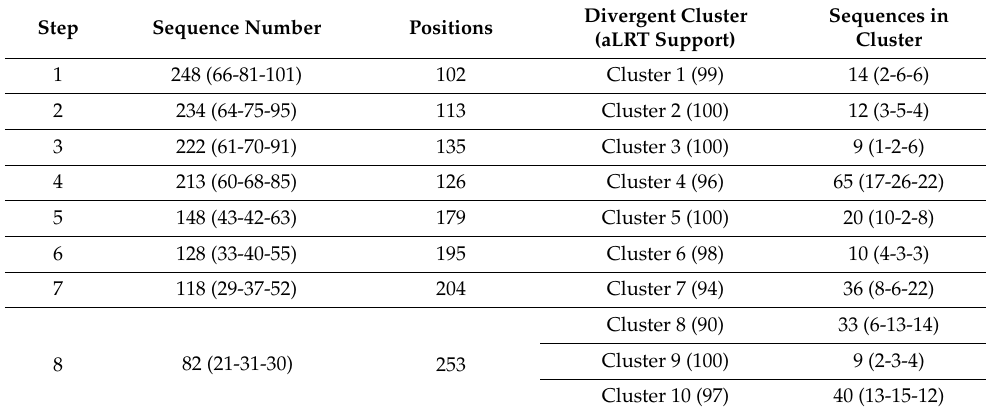
Table 1. Iterated phylogenetic analyses.